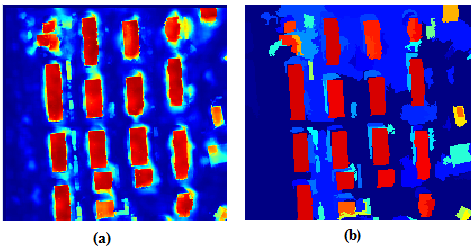
Figure 5. Comparison between BPM (a) and OBPM (b).